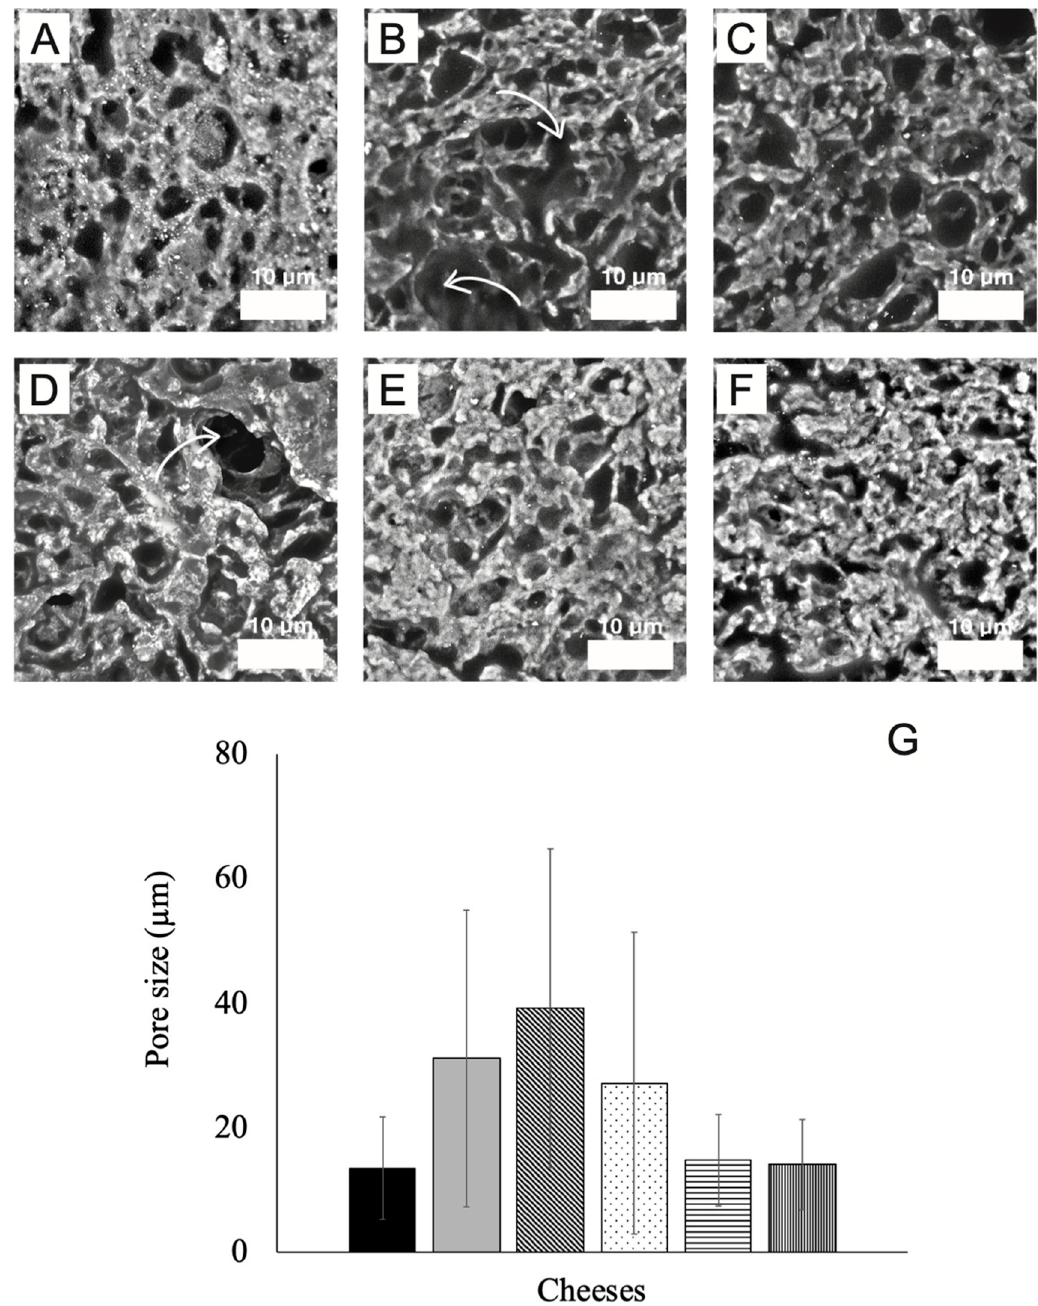
Figure 4. Scanning electron micrograph of costeño-type cheese at 10 µ m scale at 4500 × . Qc ( A ), Q 1 ( B ), Q 2 ( C ), Q 3 ( D ), Q 4 ( E ), Q 5 ( F ), and average pore size ( G ), where error bars represent one standard deviation. The light areas in the micrograph are the protein phase, and the dark areas are the fat or serum phase. Arrows indicate coalesced fat globules.